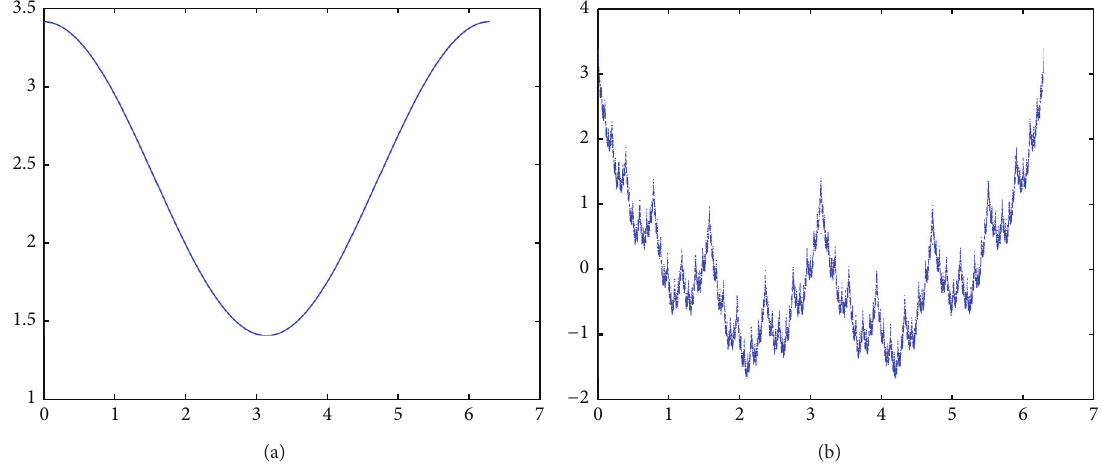
Figure 1: The graph of 𝑔(𝑥) in Example 7 with 𝜆 = 0.5 and the graph of the corresponding Weierstrass function 𝑊 𝜆 (𝑥) with 𝜆 = 0.5 .